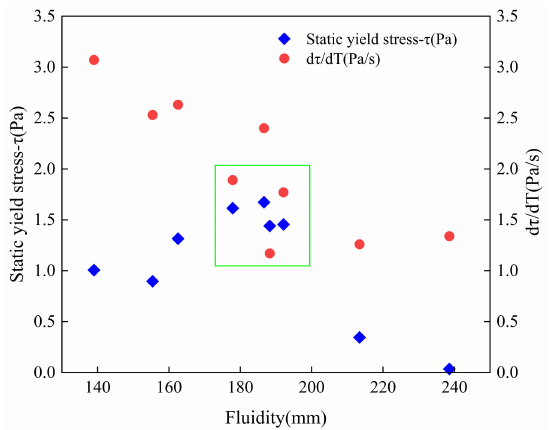
Figure 18. The printable window of static yield stress, RST and